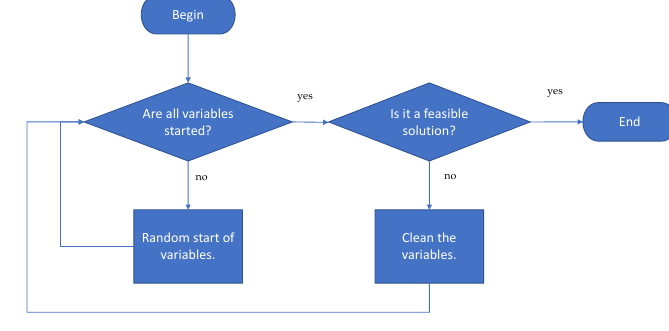
Figure 5. Solution initiation procedure.